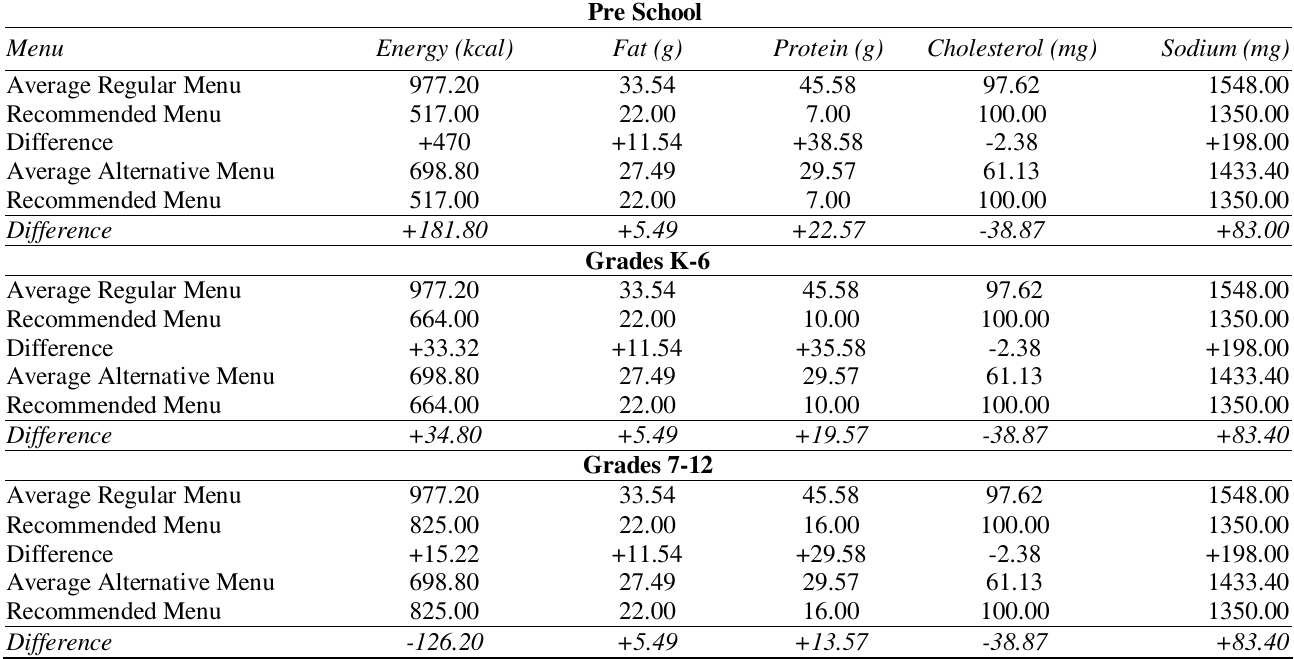
Table 3: Comparison of the school lunch menus of Canton Public Schools with the recommended